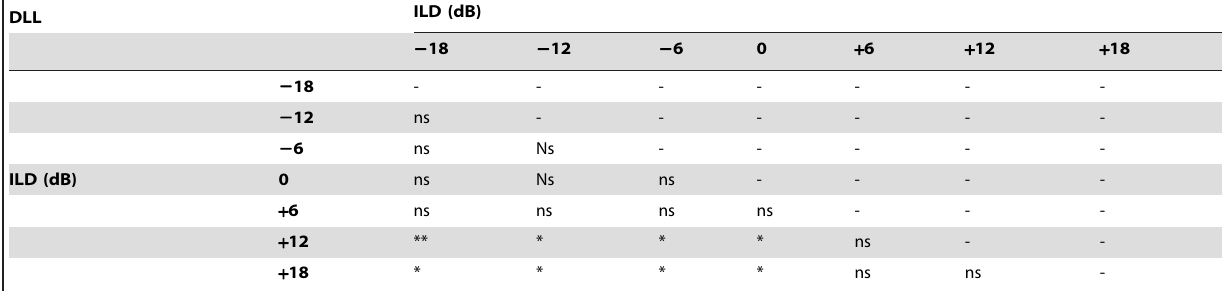
P-value table computed from the BOLD signal ratios measured from the dorsal lateral lemniscus (DLL) of all animals. In general, ratios measured at zero and negative ILDs are statistically significantly greater than those measured at + 12dB and + 18dB ILD (p , 0.05).